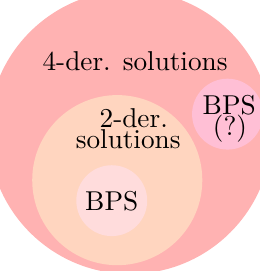
Figure 1 . Schematic diagram of the spectrum of solutions of minimal supergravity with arbitrary four-derivative terms. The subset of two-derivative solutions and their supersymmetric properties remain unchanged within the set of all possible four-derivative